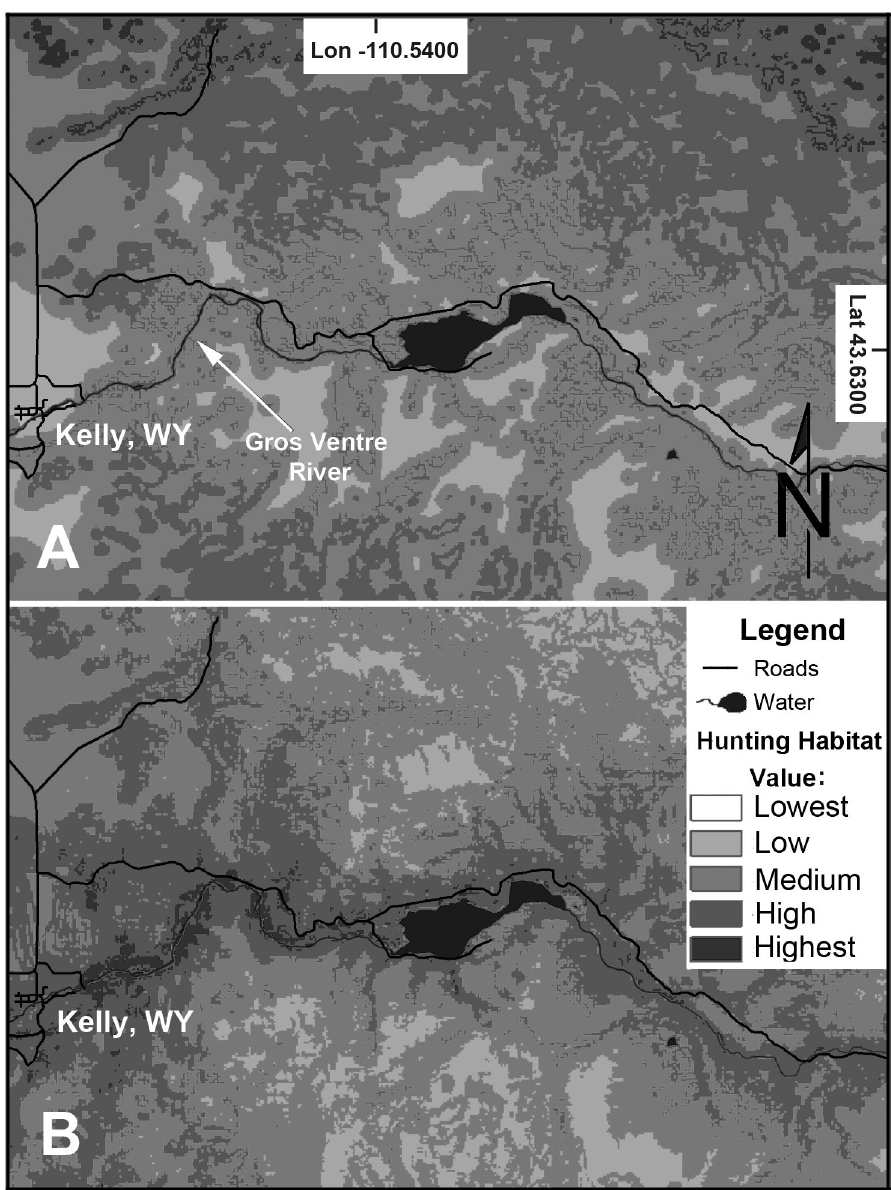
Figure 4. Seasonal habitat use by cougars. A comparison between Summer (A) and Winter (B) habitats utilized by cougars projected across the landscape based upon outputs from our Resource Selection Function outputs. The central body of water is Lower Slide Lake in the Bridger-Teton National Forest. Note the position of the Gros Ventre River, which we highlighted to emphasize the influence of “distance to water” in seasonal hunting.